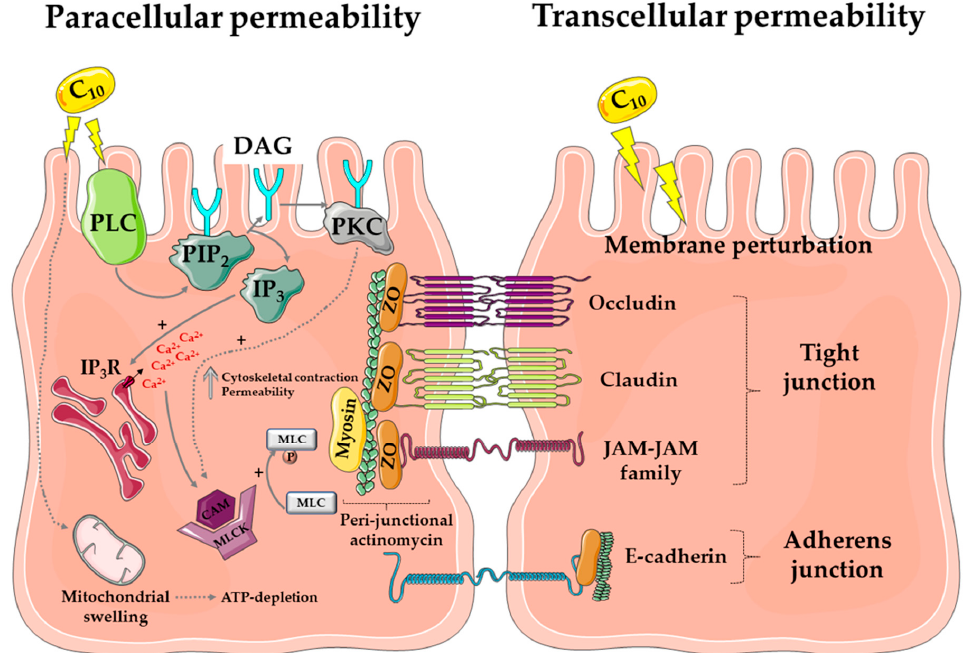
Figure 2. Mode of action of C 10 . The diagram represents the proposed mechanism of action of C 10 via paracellular flux ( left ) and transcellular perturbation ( right ) to induce drug permeability across